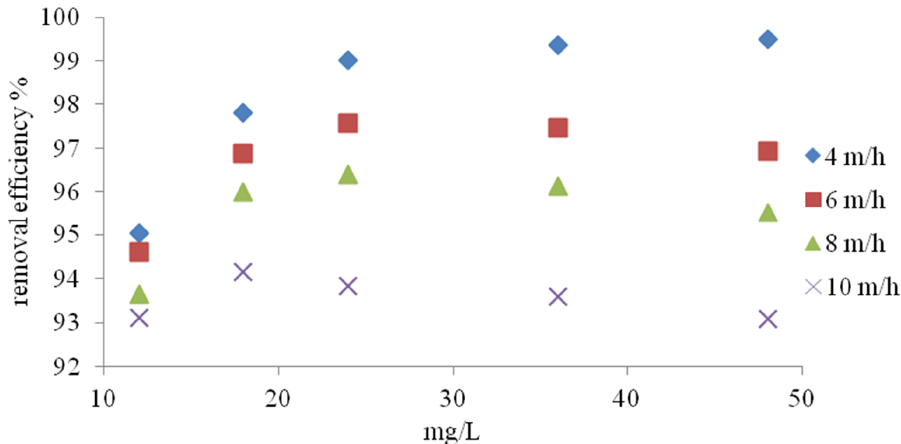
Figure 10. Effect of flow rate on the removal efficiency of different ammonia concentrations from NH 4 Cl solution in distilled water.